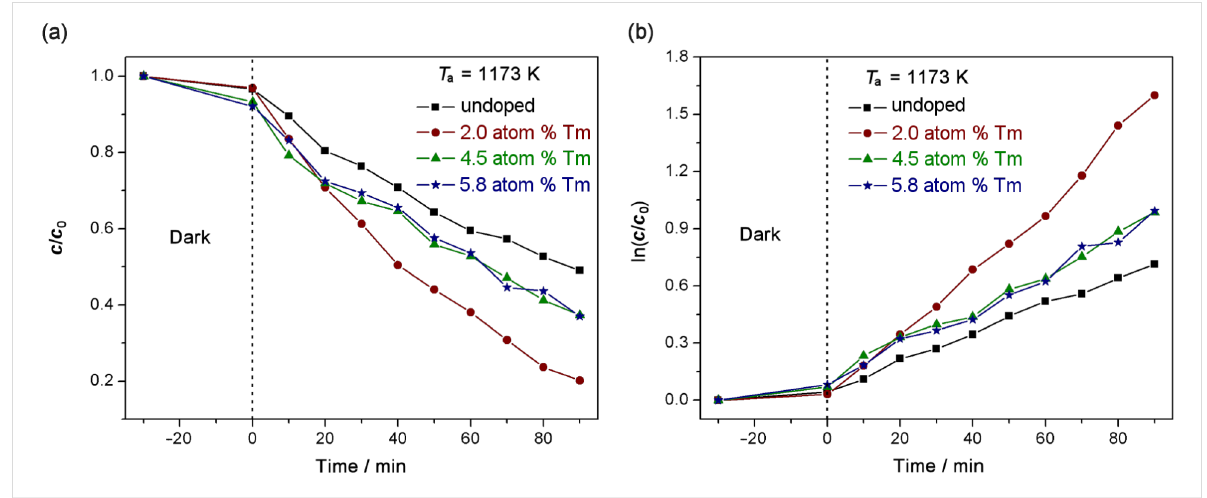
Figure 8: Photodegradation of MB under UV irradiation using the samples annealed at 1173 K as catalyst.